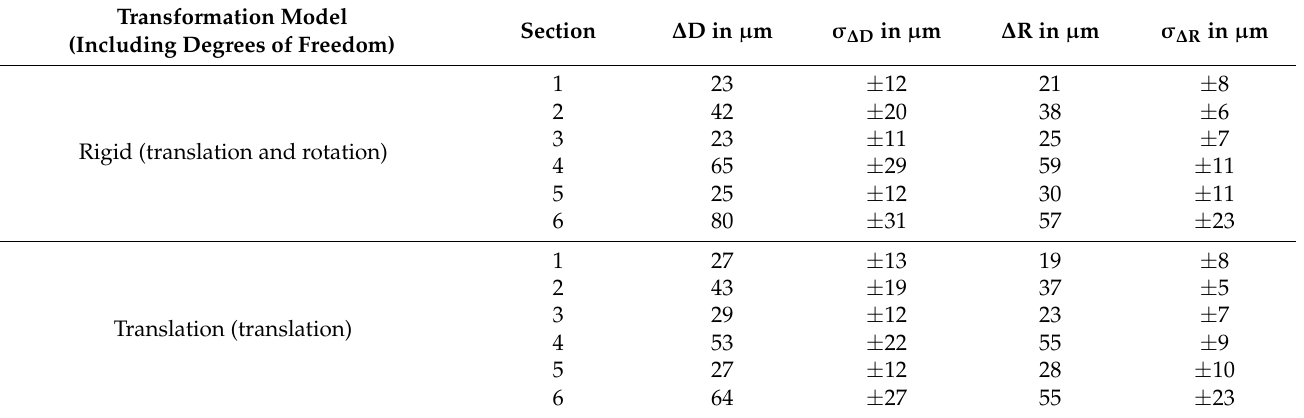
Table 4. Geometric errors resulting from different transformation modes of registration in the corresponding sections. Here, ∆ D corresponds to the MAE of the distance between the circle fit centroids and ∆ R to the MAE of the difference between the circle fit radii. The STD of both sizes is given by σ ∆ D and σ ∆ R ,